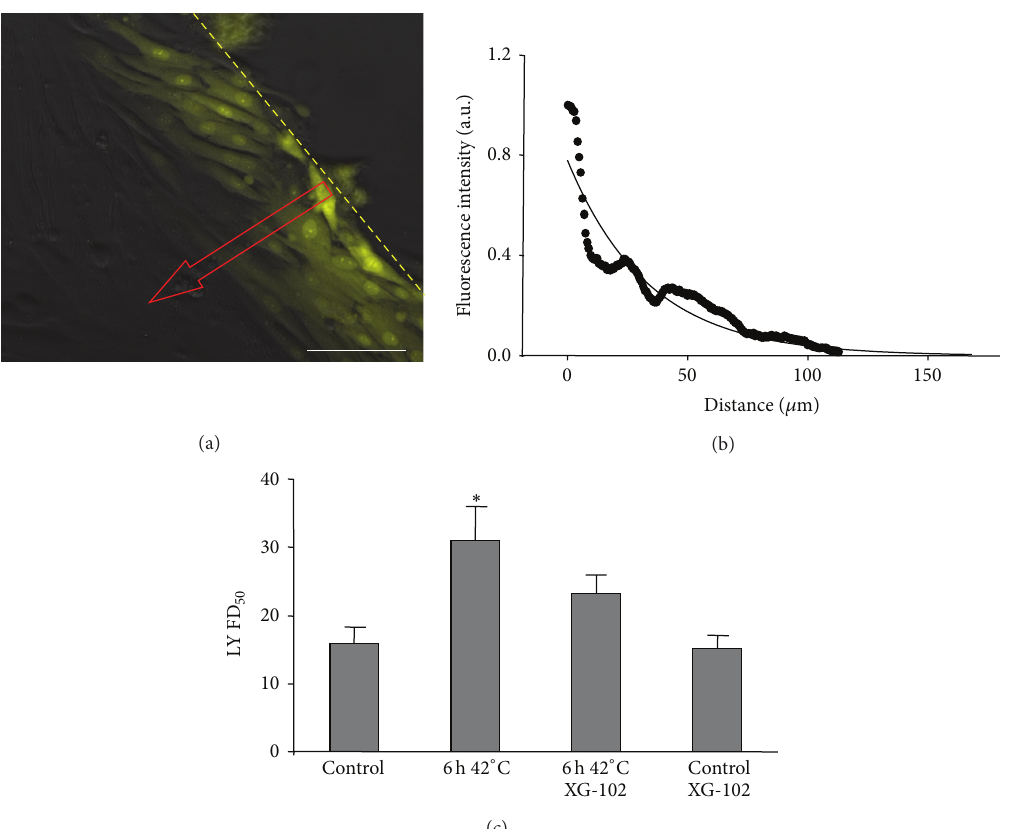
Figure 2: Effect of hyperthermia on Cx43 GJIC in SkMs. (a) LY diffusion between SkMs was measured by the scrape-loaded dye transfer technique (dashed line indicates the scrape margin; arrow shows the measurement direction of the LY diffusion). (b) Kinetics of scrape- loaded LY diffusion under control conditions, measured 3 min after LY application. Raw data were fitted with an exponential decay function. (c) Comparison of scrape-loaded LY diffusion under control and hyperthermia conditions in the presence and absence of XG-102 (4 𝜇 M). FD 50 was 15.7 ± 2.4 , 30.3 ± 5.4 , 15.1 ± 1.6 , and 22.5 ± 2.8 𝜇 m, respectively. 𝑛 = 10 in each set of experiments; ∗ = 𝑃 < 0.05 , ANOVA followed by post hoc Dunnet’s test. Scale bar 100 𝜇